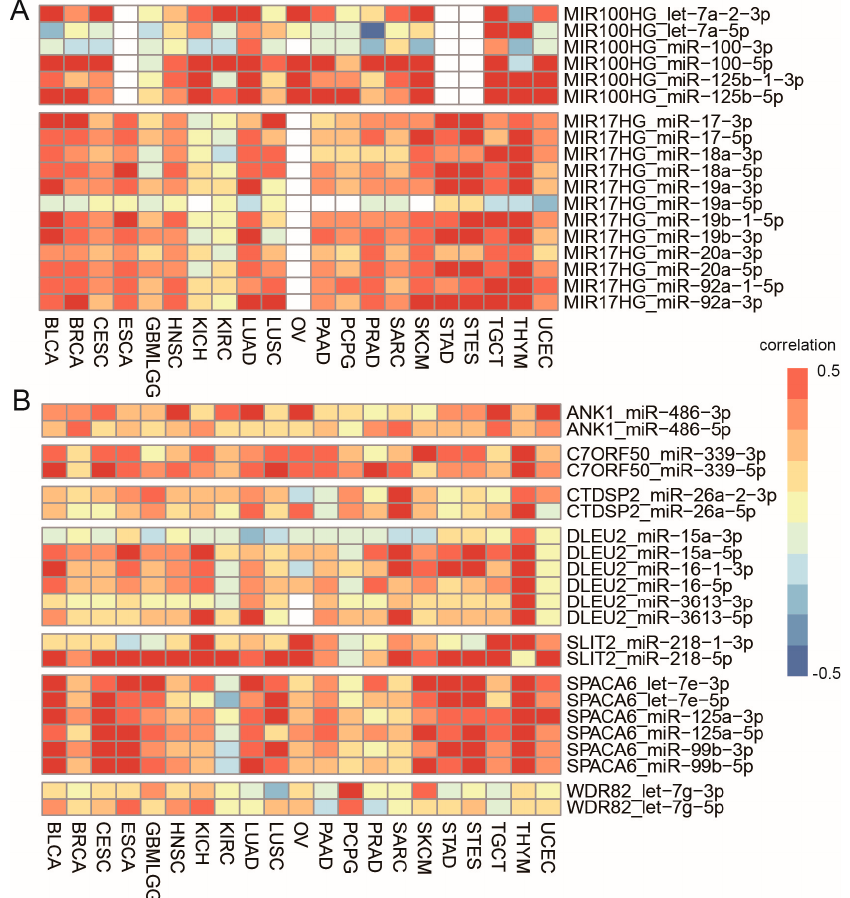
Figure 4. ( A ). miRNA clusters with altered co-transcriptional patterns in different cancer types. ( B ). precursor miRNAs with altered 5 ′ and 3 ′ strand that were highly correlated with their host genes in different cancer types.